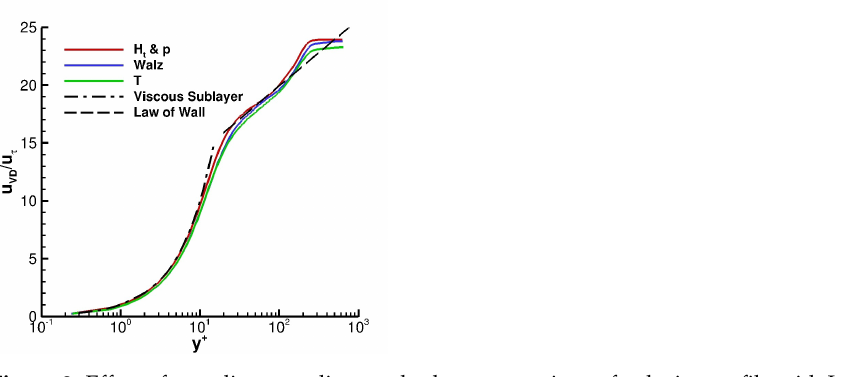
Figure 2. Effect of recycling-rescaling method on comparison of velocity profile with Law of Wall at x / δ = 20 for Condition No.